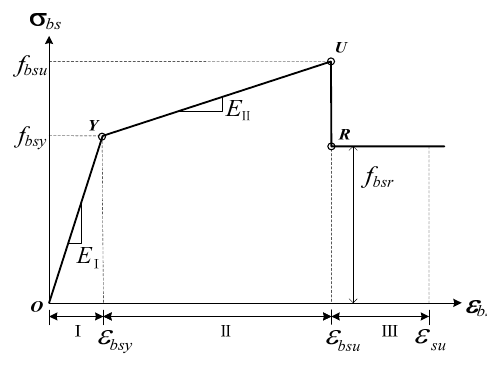
Figure 10. The stress-strain relationship of